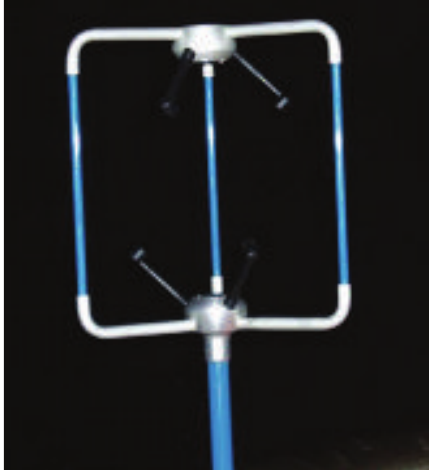
Figure 6: 3D sonic anemometer.